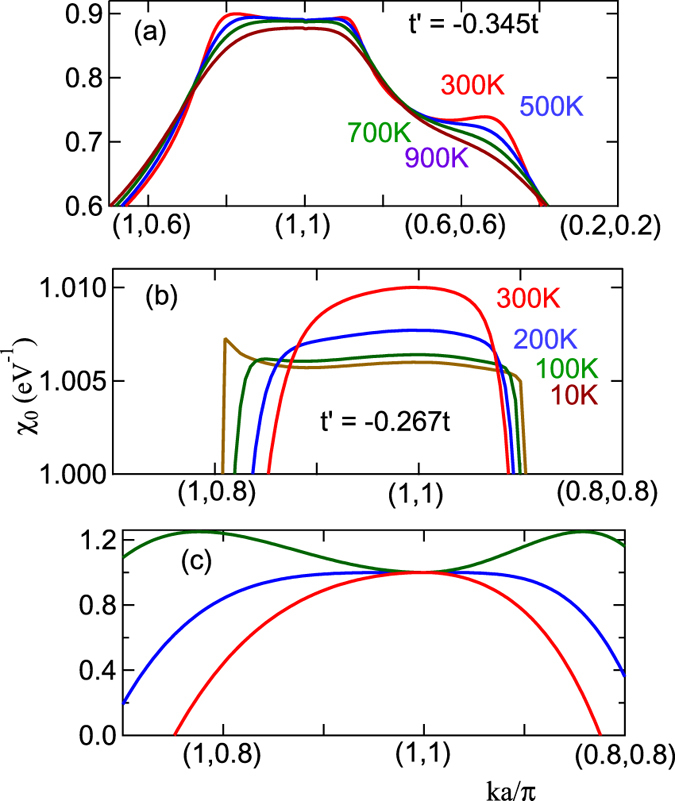
Susceptibility near commensurate-incommensurate transition in t − t′-model.For (a) t′ = −0.345t and (b) t′ = −0.267t. (c) A simple ‘Mexican hat’ model, , for , with A4 > 0 and varying A2: A2 > 0 (red line), χ = 0 (blue line), and <0 (green line).